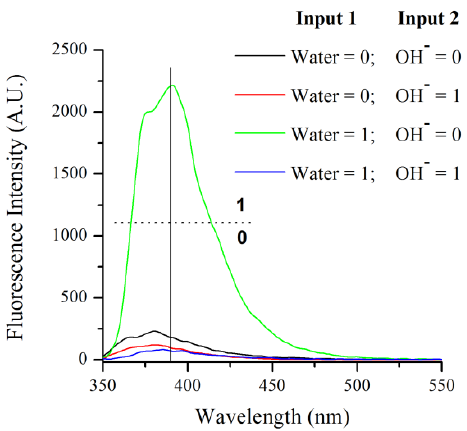
Figure 4. The changes in the fluorescent intensity ( λ ex = 340 nm) of probe 4 (C = 10 − 5 mol/L) in ethanol, with Water (50% content) and Base (C = 10 − 6 mol/L) as chemical inputs. As chemical inputs in this logic gate, NaOH (10 − 6 mol/L) and water (50% content) in